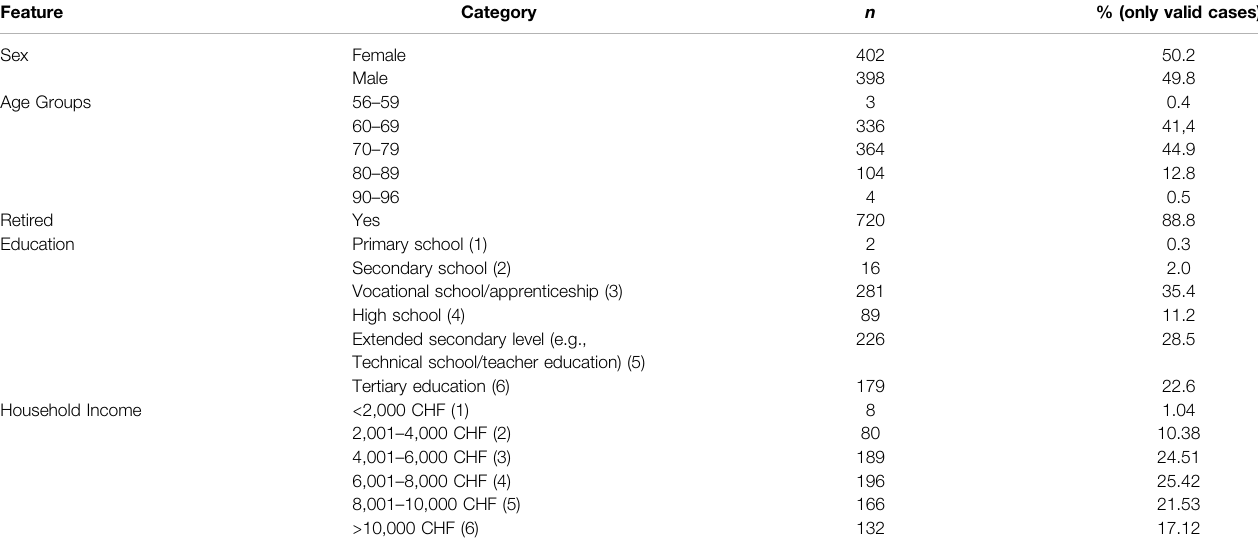
TABLE 1 | Summary of the study sample from the SU.